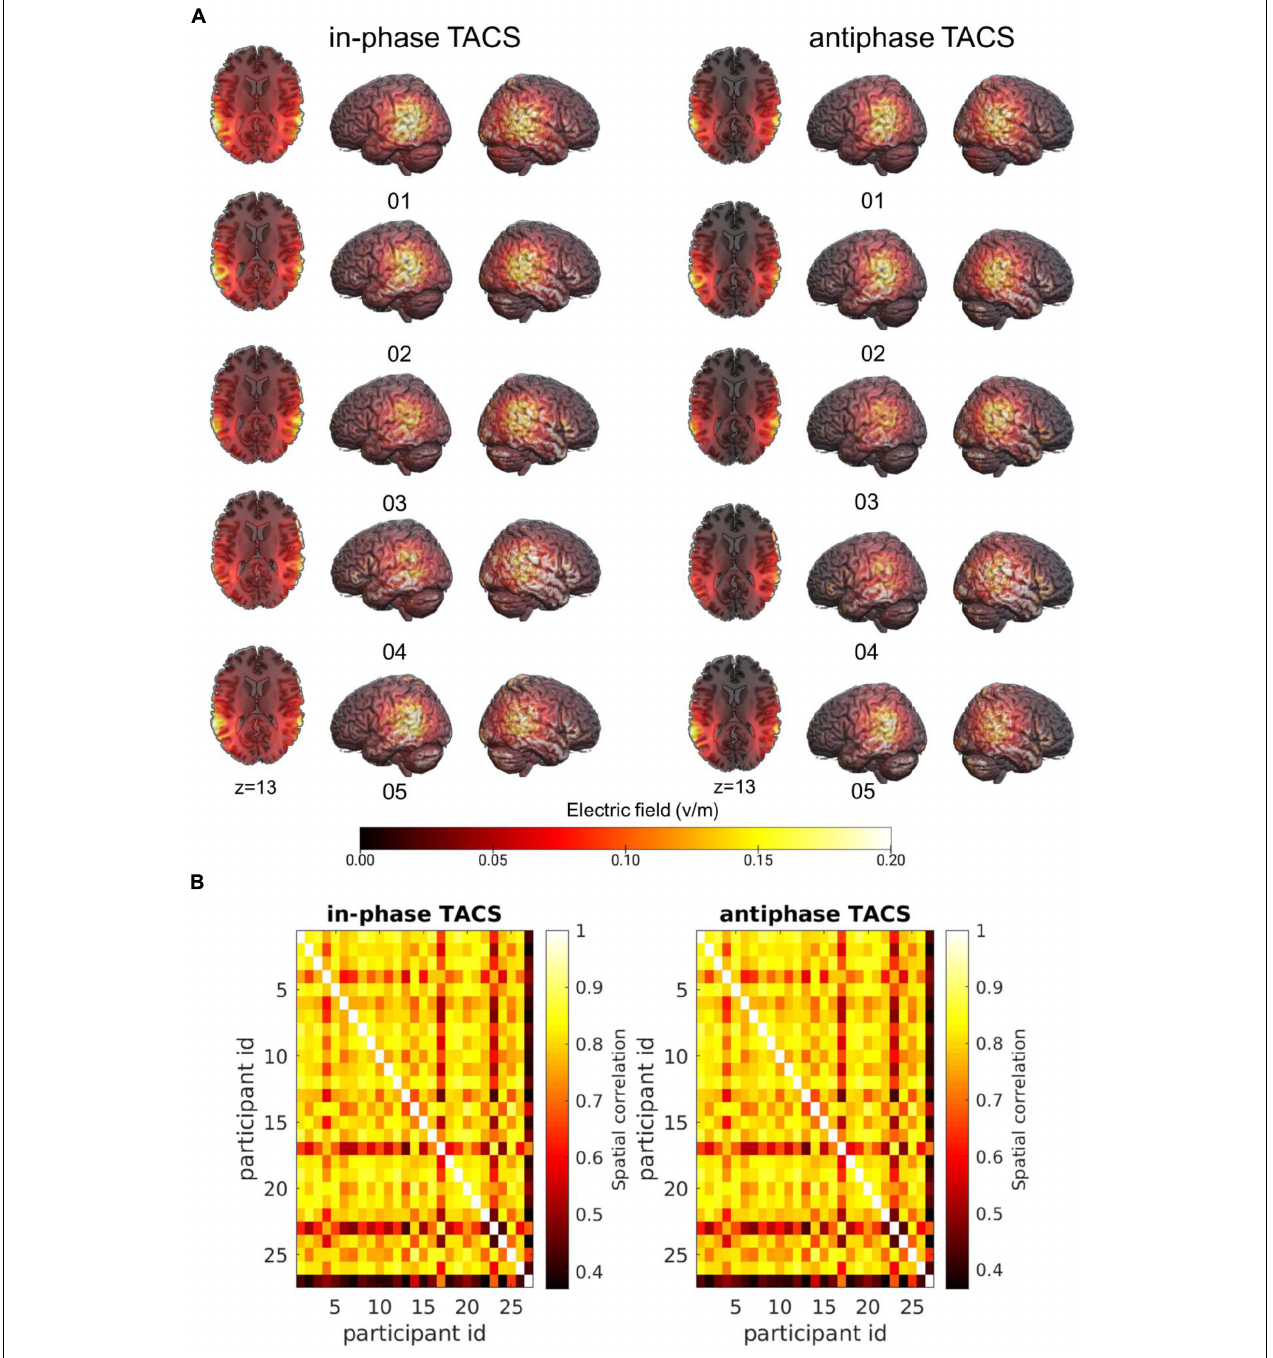
FIGURE 3 | Individual variability of the electric field across participant. (A) Simulations of the electric fields with concentric ring electrodes centered over CP5 and CP6 (see section “Materials and Methods”) applied at 1.5 mA (peak-to-peak) illustrated for five participants in each tACS condition (tACS 0 ◦ ; tACS 180 ◦ ). Simulations were performed on the native image space of the participant and warped into MNI space for visualization purposes. (B) Spatial Pearson correlations between the electric fields of individual participants separated by tACS condition.